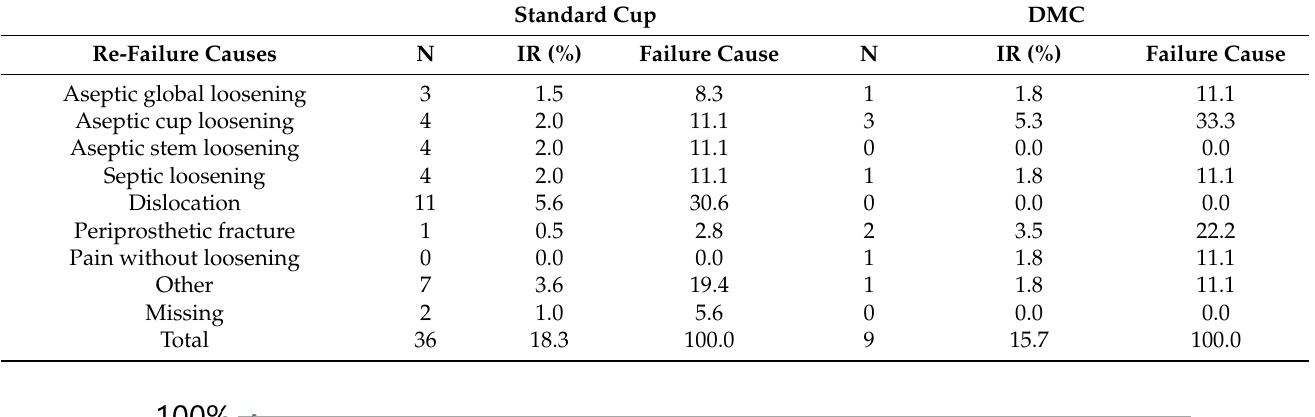
Table 5. Summary of re-failure causes.